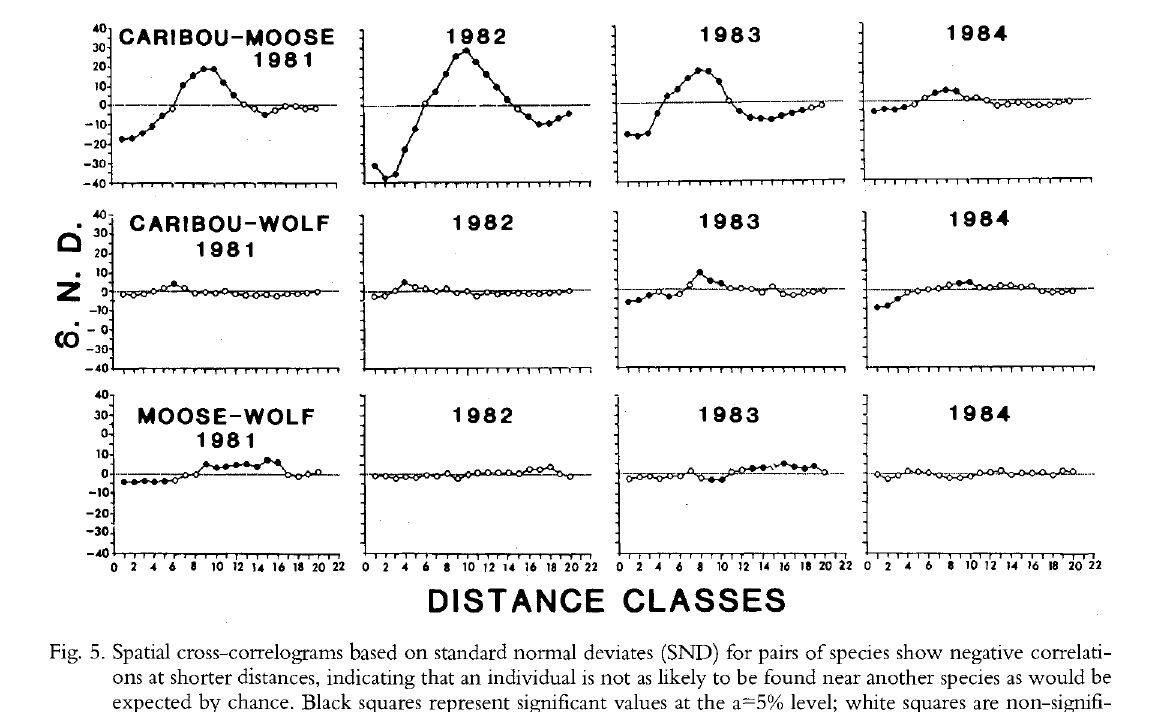
ted clumped dispersion for caribou was indicated by numbers well below one. A similar low index, but less pronounced, was shown for moose, confirming that moose also clumped together at least to some extent.